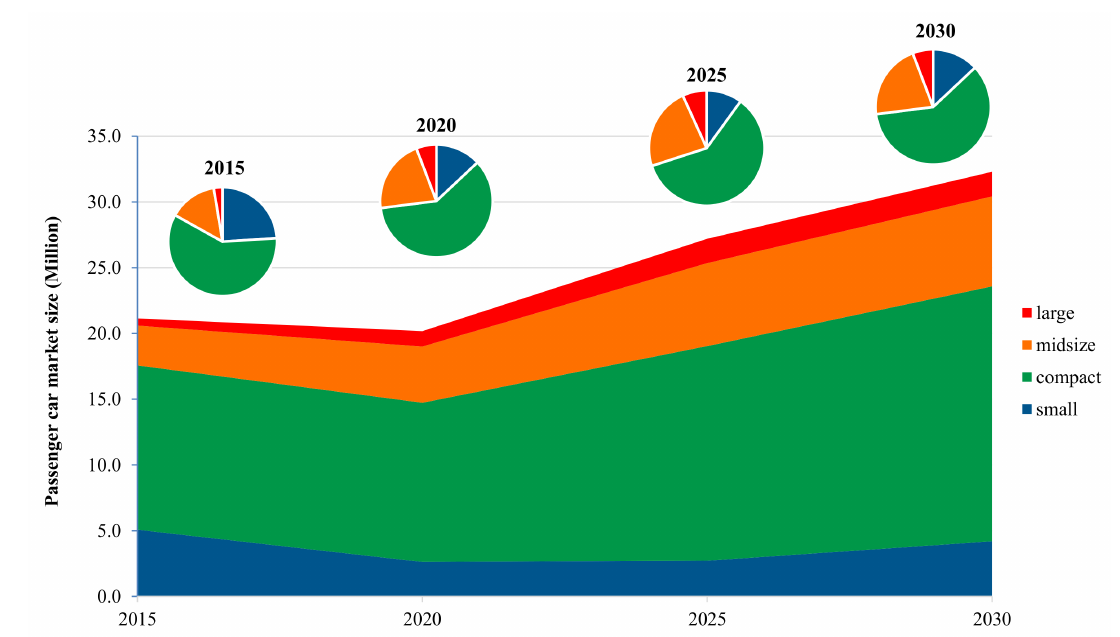
Figure 9. Structure development of China’s passenger car market.